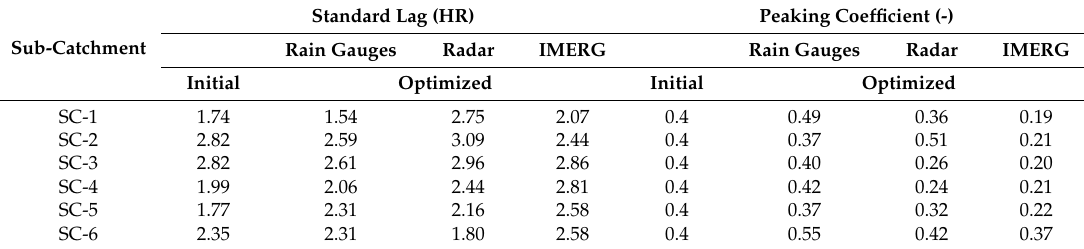
Table 9. Calibrated model parameters for Snyder Unit Hydrograph Transform Method.